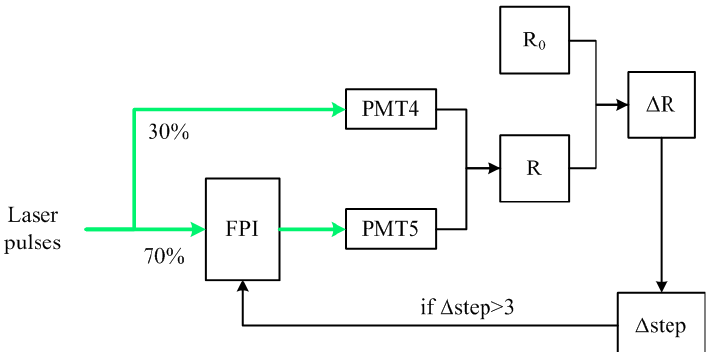
Figure 5. The procedure of frequency locking. R is the ratio of the two signals; R 0 is the reference ratio; ΔR is the deviation of the signal ratio; Δstep is the converted FPI step.